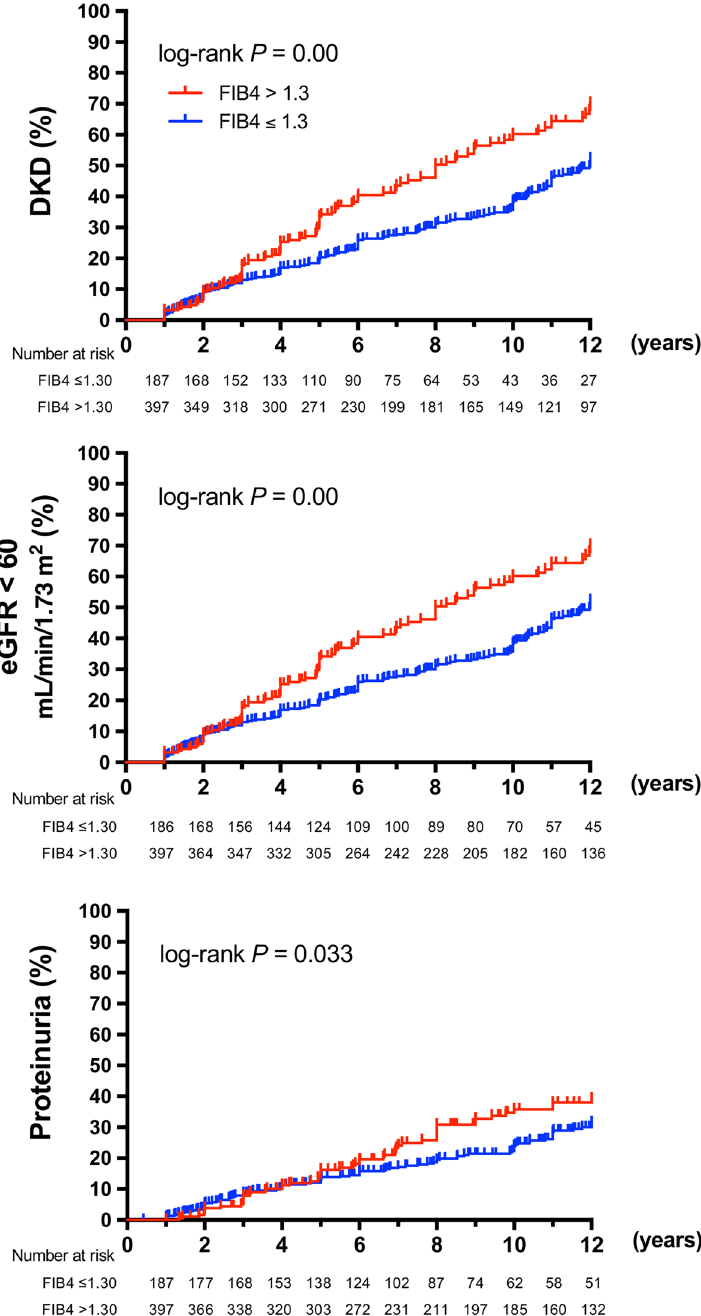
Figure 2. Kaplan Meier curves for the development of ( A ) diabetic kidney disease (DKD: eGFR < 60 mL/ min/1.73 m 2 or proteinuria), ( B ) eGFR < 60 mL/min/1.73 m 2 , and ( C ) proteinuria in type 2 diabetic patients with FIB4 index > 1.3 (red lines) or ≤ 1.3 (blue